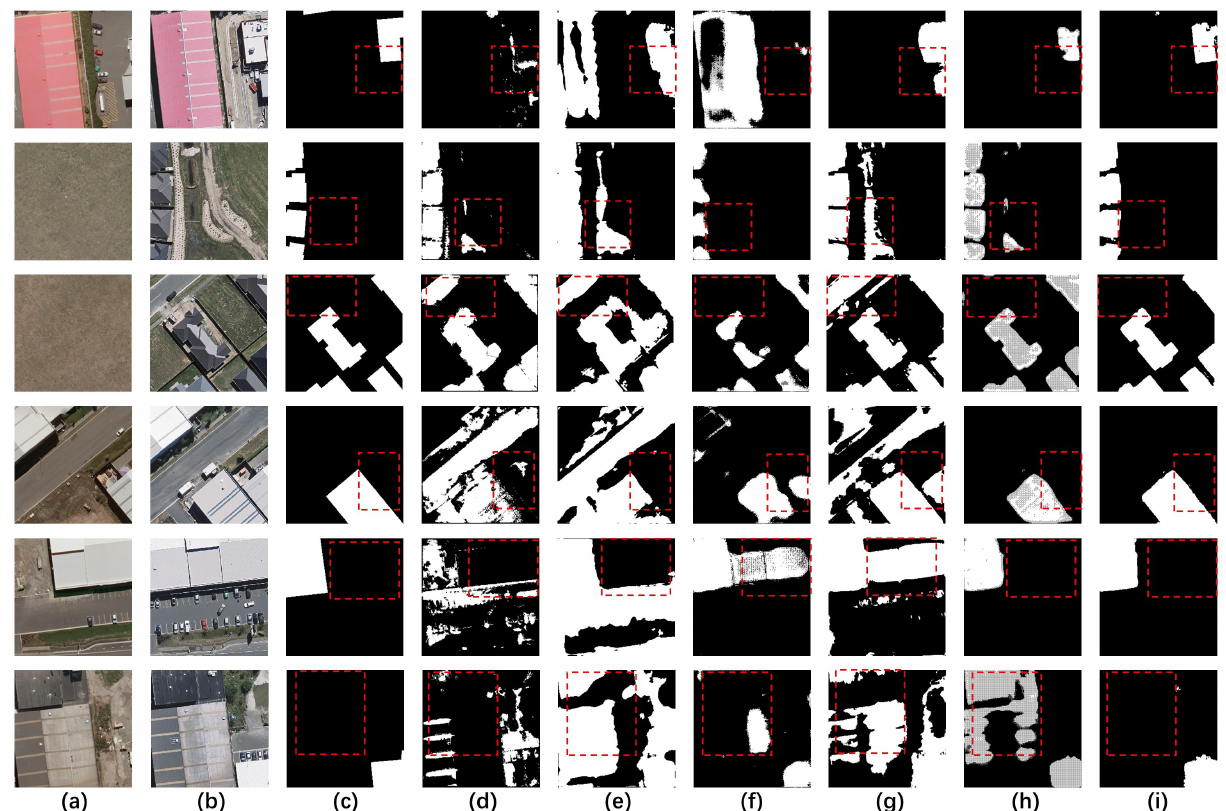
Figure 7. Visual comparisons of CD maps by different approaches on WHU dataset using 10% labeled images for training. ( a ) Image T 1 .( b ) Image T 2 . ( c ) Ground truth. ( d ) Fc-Diff. ( e ) Fc-Conc. ( f ) SNUNet-ECAM. ( g ) s4GAN. ( h ) semiCDNet. ( i )